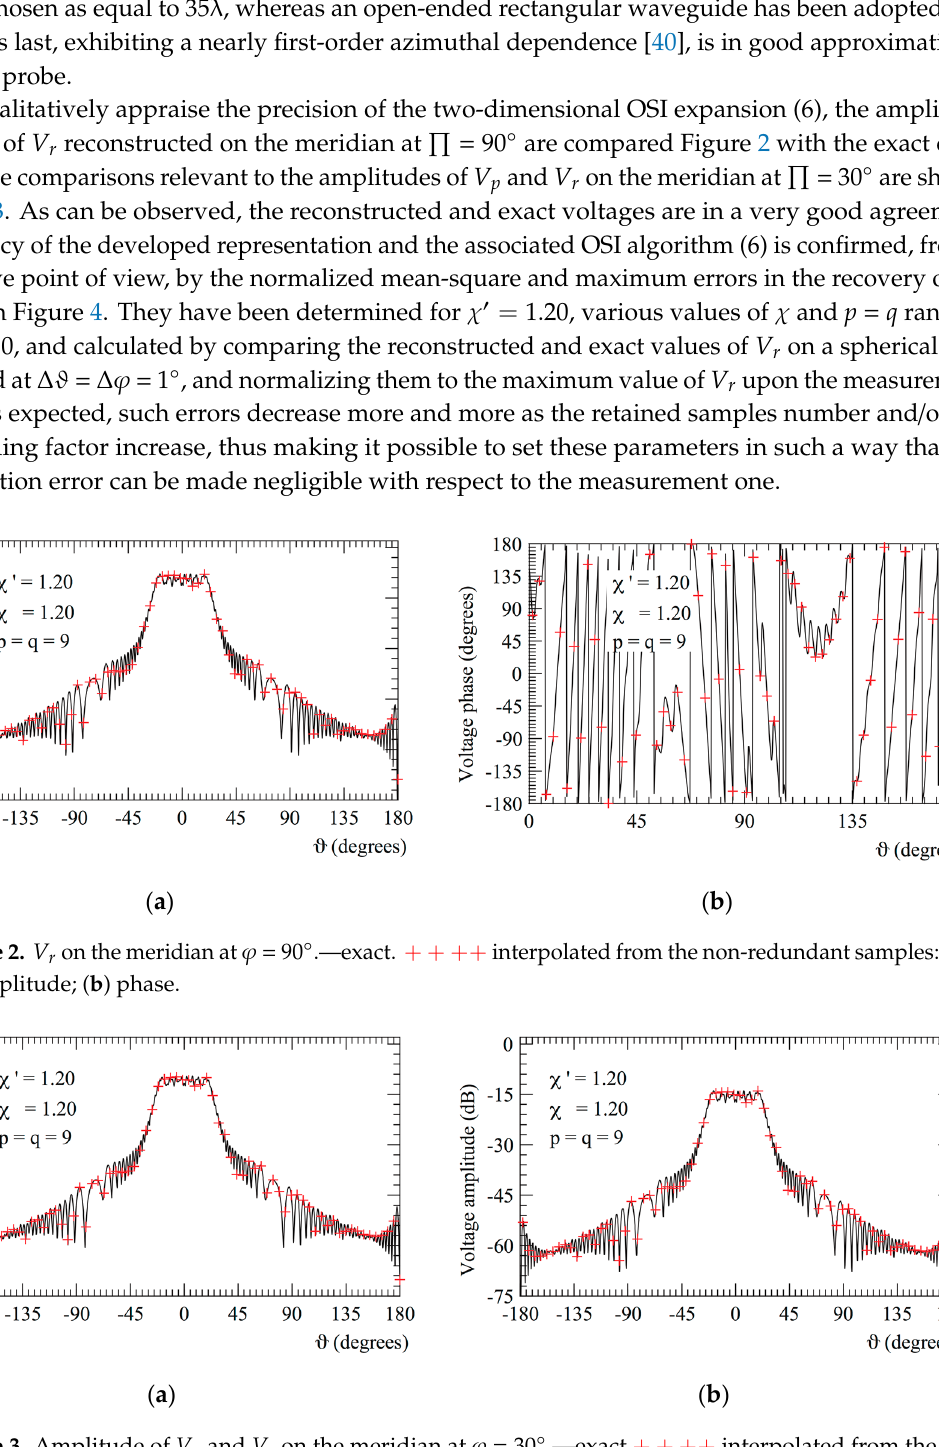
( a ) ( b ) Figure 4. Errors in the reconstruction of r V : ( a ) maximum error; ( b ) mean-square error. ( a ) ( b ) Figure 5. Far-field pattern. ――― exact. + + + + interpolated from the non-redundant samples: ( a ) E-plane; ( b ) H-plane. For sake of comparison, it must be emphasised that the above recoveries have been attained by employing a much lower number of NF data (17,483), as compared to that (45 , 300) needed by the classical NTFF transformation technique [14]. Note that such a number is also much smaller than that required by Foged’s approach [36], making use of a number of NF samples a bit greater than that (29,040) necessary for employing the transformation technique [14] in the case of a centered mounting.